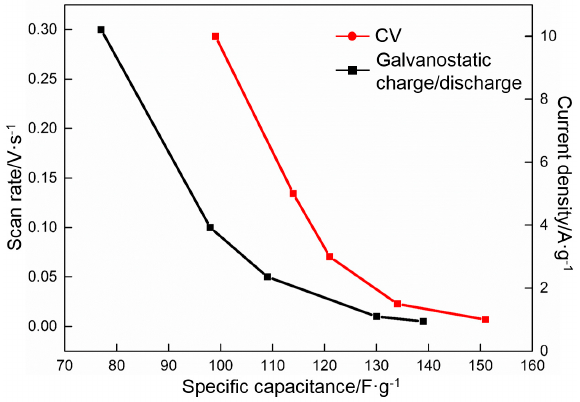
Figure 15. Specific capacitance of RGO as a function of scan rate and current density.